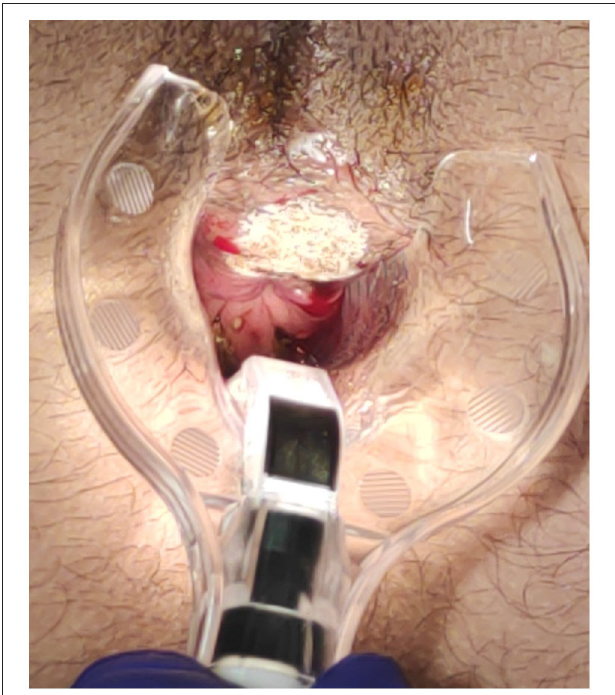
FIGURE 2 | Anterior fissure: sentinel sking tag CO 2 laser scanner vaporisation.